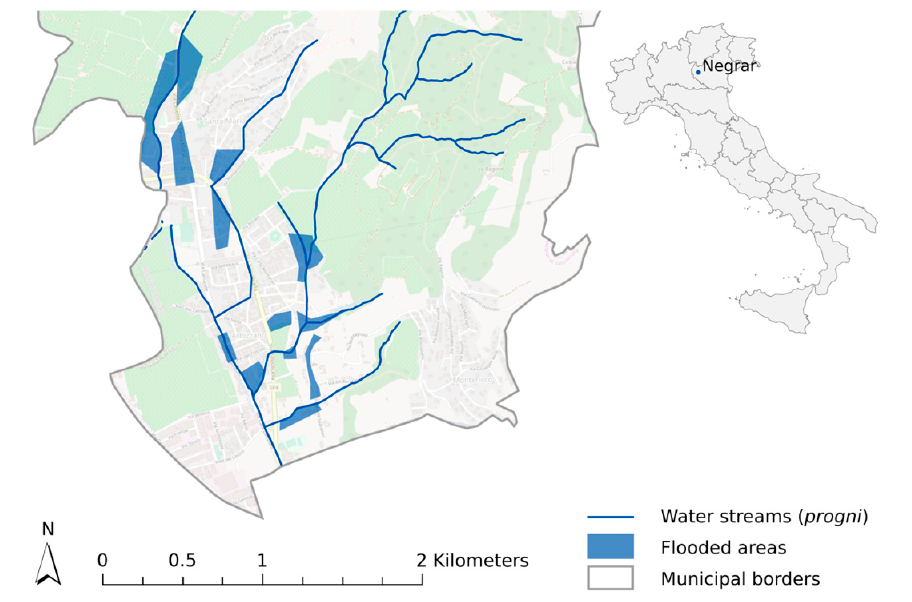
Figure 1. Study site location and flooded